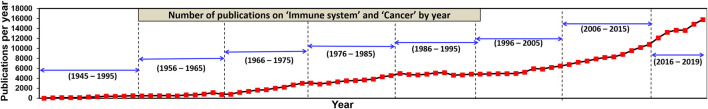
Year-wise number of publications on 'Immune system' and 'Cancer' from the year 1945–2019. As per the data available on PubMed.